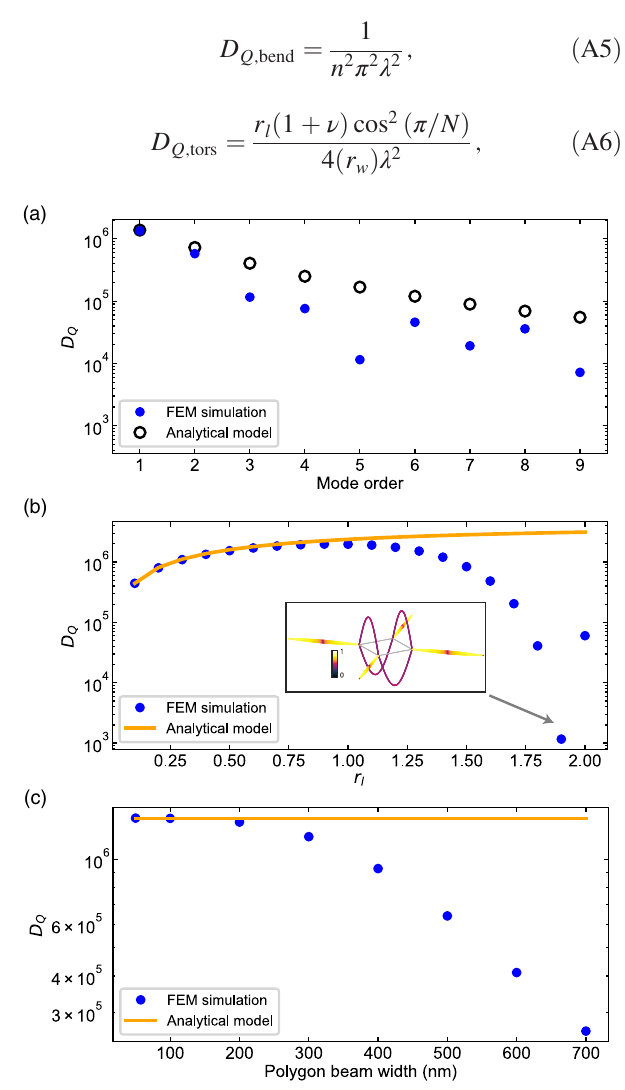
FIG. 7. Theory model and FEM simulation comparison. We compare simulation and analytical predictions for a polygon resonator with N ¼ 4 , l 0 ¼ 700 μ m, and uniform stress ffiffiffi p 2 ( r ). (a) Dilution factor ( D ) for different perimeter modes w ¼ Q 0 . 4 ). (b) D ( w 0 ¼ 200 nm, r of the first perimeter mode as the l ¼ Q support length is varied (fixed w 0 ¼ 200 nm). The inset shows the mode displacement for r ¼ 1 . 9 , with the color encoding the torsional energy density. (c) D of the first perimeter mode as Q 0 . 4 the width of all the segments is varied (fixed r l ¼